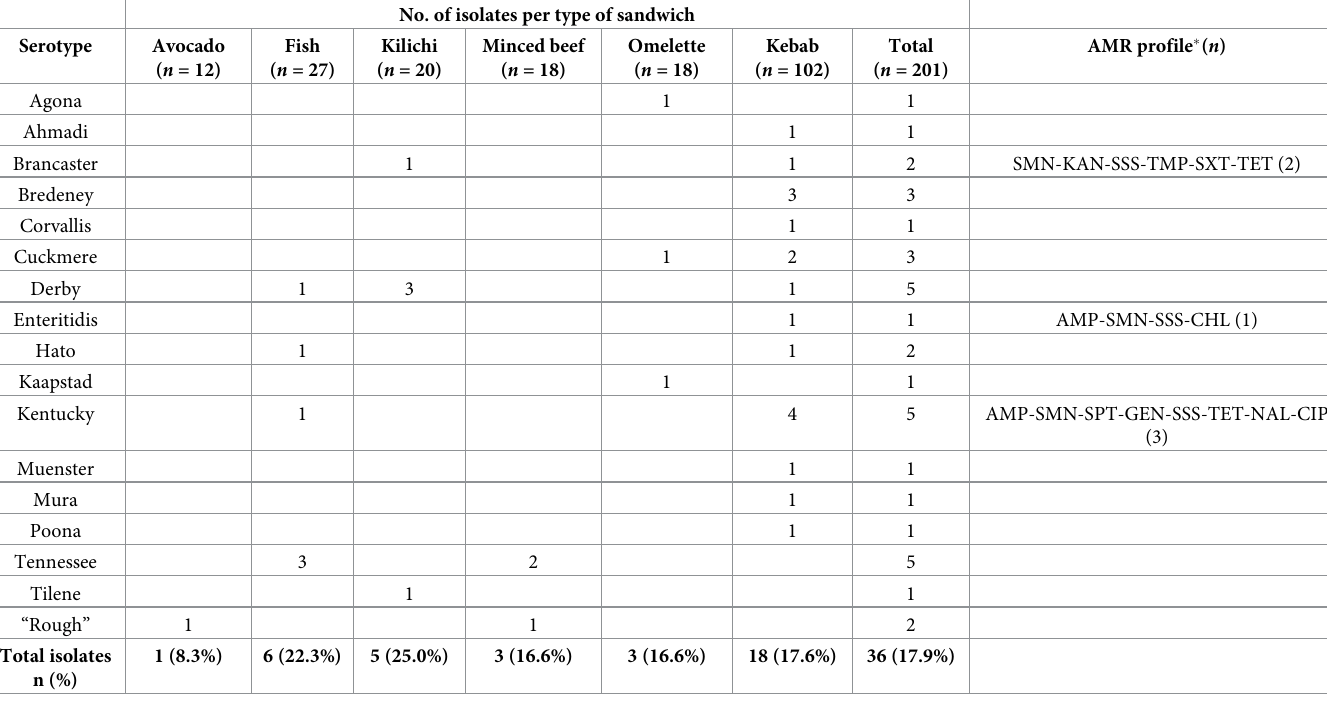
Table 2. Serotypes of Salmonella enterica isolated from sandwich samples and their antibiotic resistance